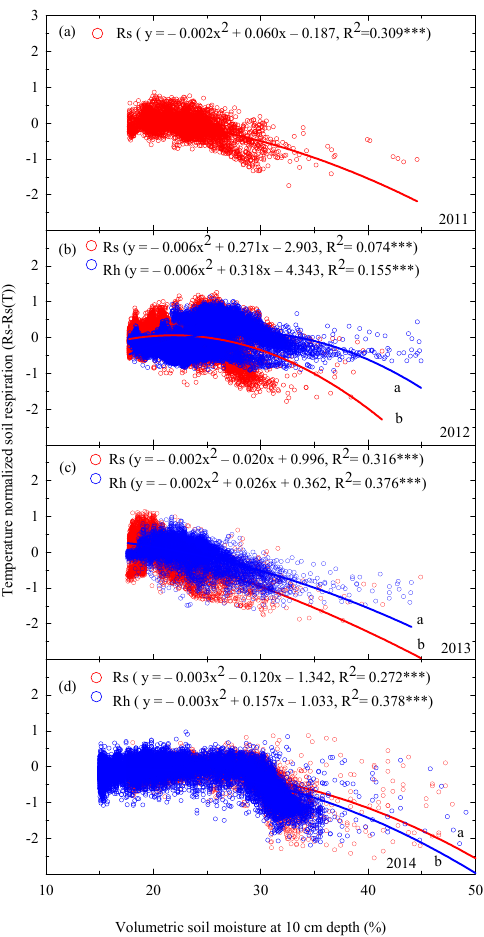
Figure 5. Relationships between half-hourly temperature-normalized soil respiration (Rs), hetero- trophic respiration (Rh), and hourly volumetric soil moisture at 10 cm depth (%) in ( a ) 2011, ( b ) 2012, ( c ) 2013, and ( d ) 2014. Asterisks indicate significance: *** p < 0.001. Different letters indicate differences between regression lines within the same year at p < 0.05.